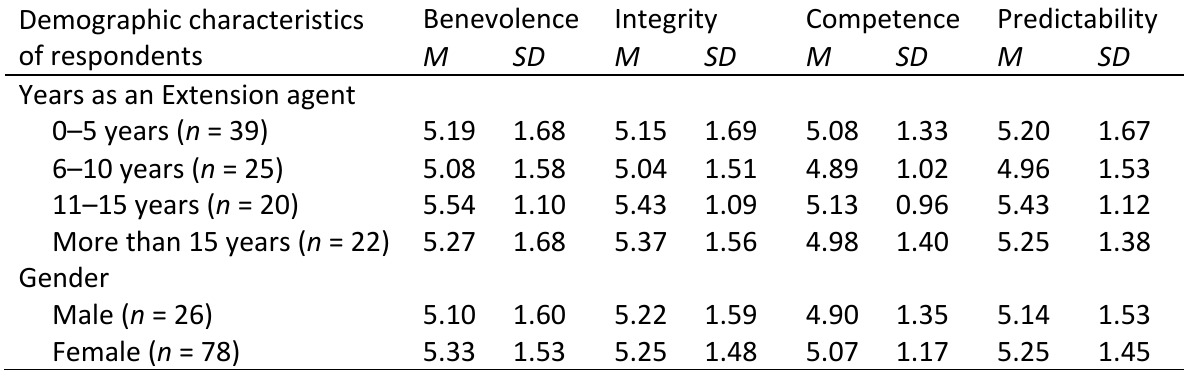
Index Means and Standard Deviations of Demographic Characteristics Related to Respondents and the TLS Antecedents Demographic characteristics